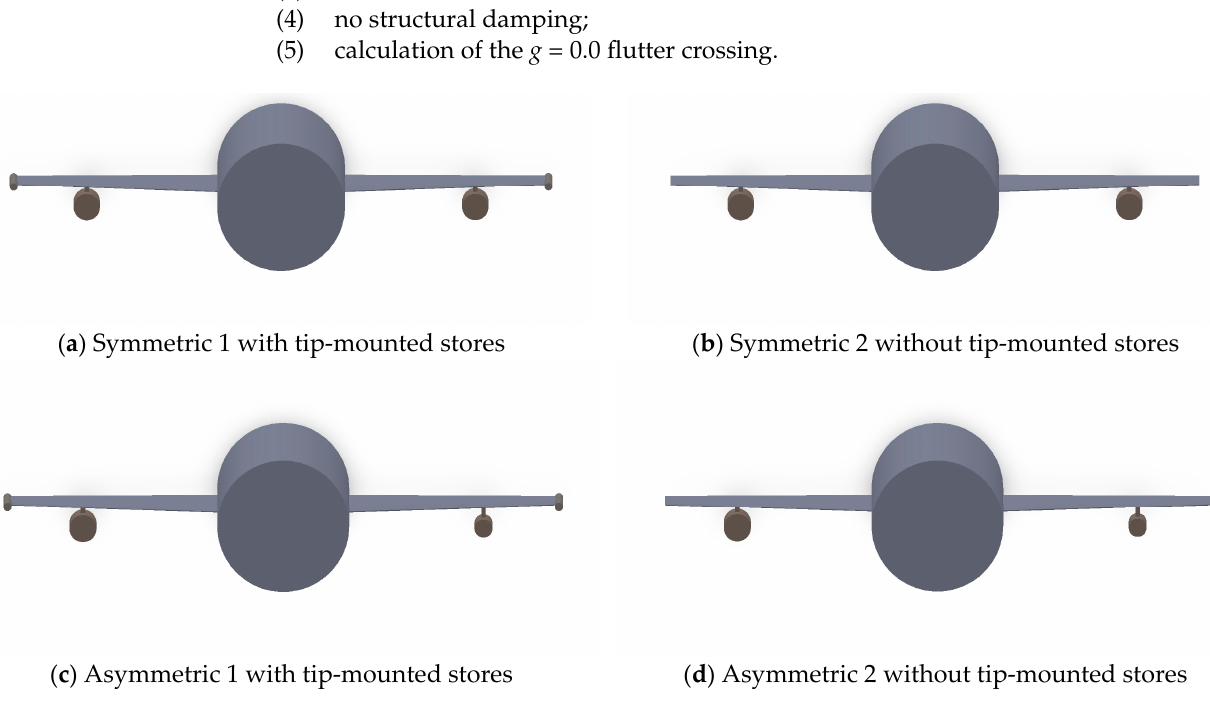
Figure 6. Illustration of the real-world jet aircraft configurations.